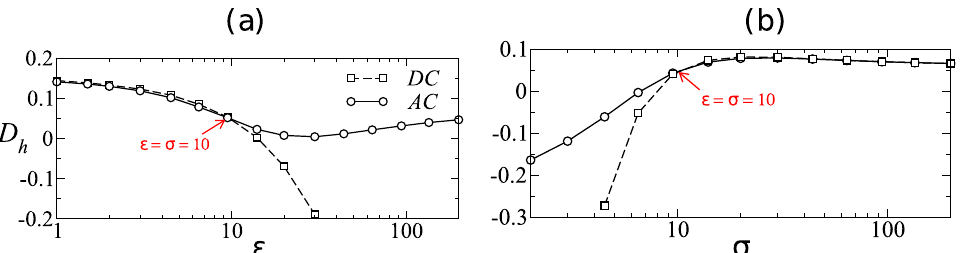
Fig. 4 Deviation in droplet deformation between AC and DC fi elds as ε > σ . Variation of fractional deviation of droplet height, D h with a ε for = 10 and for all the AC cases, Ω = π /50. σ = 10 and b σ for ε = 10. Here, O c